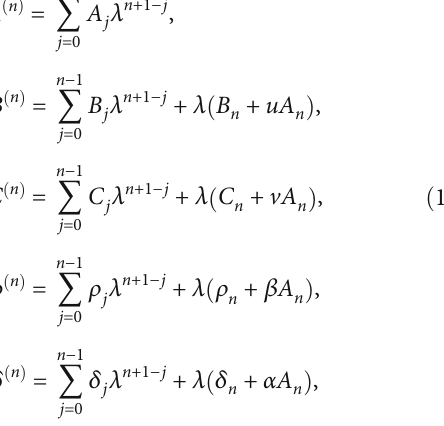
u ffiffiffiffiffiffiffiffiffiffiffiffi